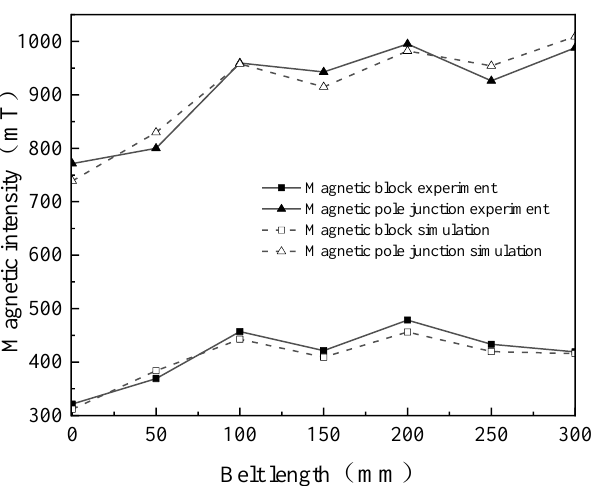
Figure 6. Comparison between simulation and experiment of longitudinal magnetic field intensity distribution on belt surface.